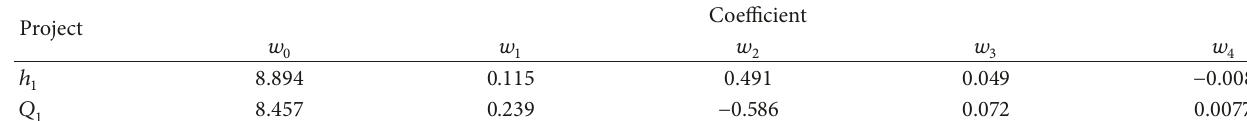
Table 5: The coefficients of regression equation.